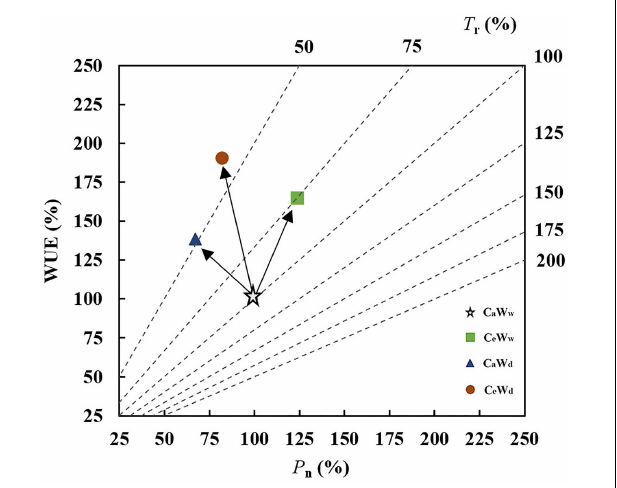
FIGURE 5 | Graphical vector analysis (GVA) showing the effects of e[CO 2 ] and water status on P n , T r , and WUE (C e W d , orange circle; C e W w , green box; C a W d , blue triangle; and C a W w , white